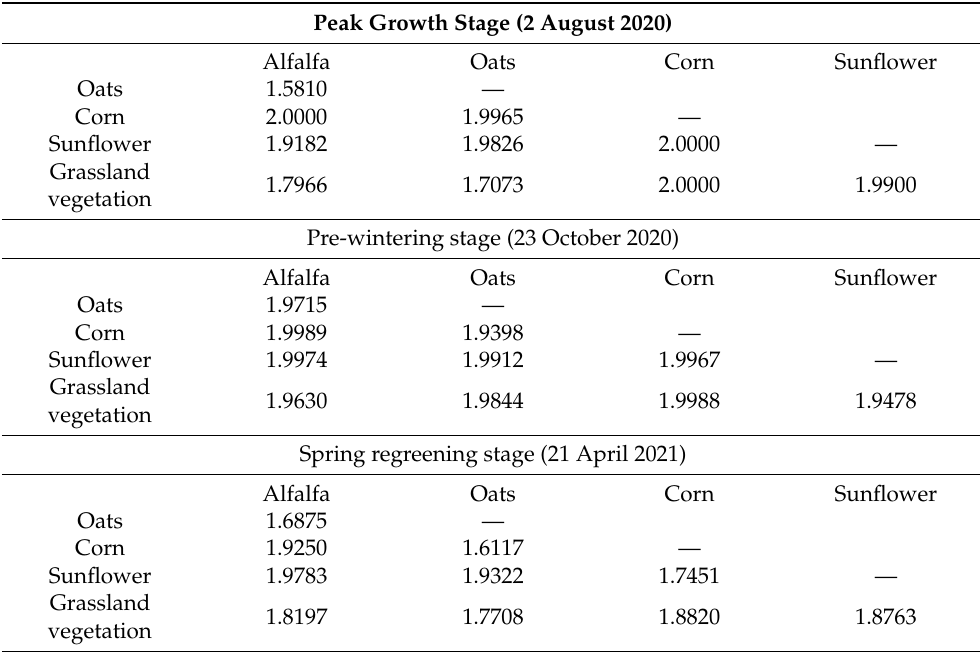
Table 3. Separability of different vegetation types at the different growth